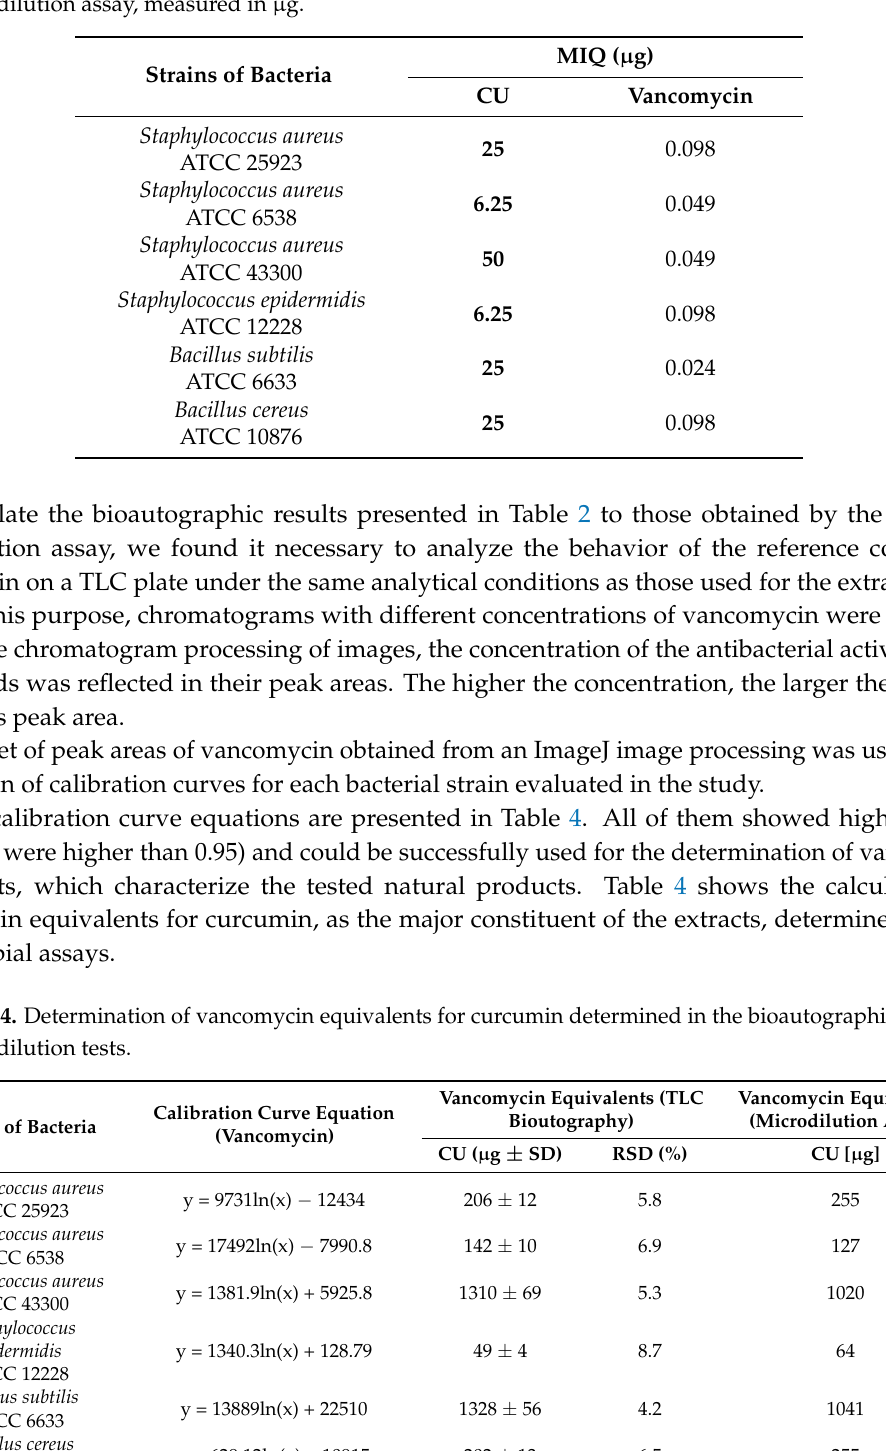
Table 3. Determination of curcumin antibacterial activity in relation to vancomycin, by a standard microdilution assay, measured in µ g.